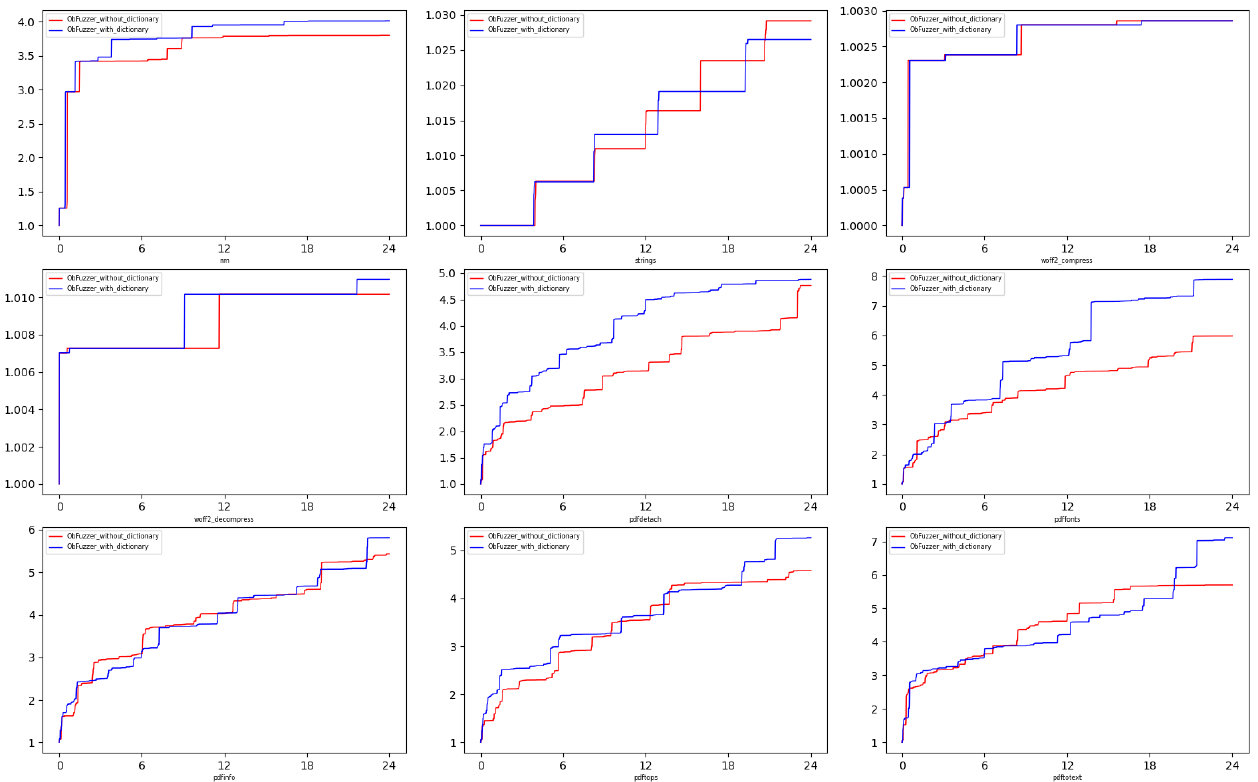
Figure 12. Object Operation Complexity of ObFuzzer with/without test case dictionary.